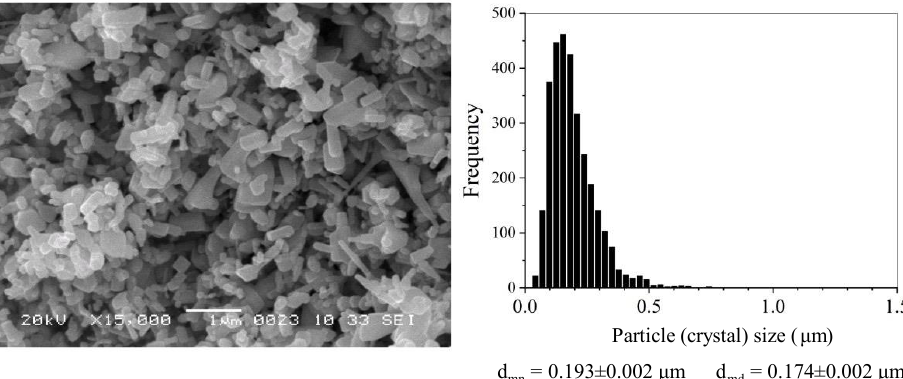
Figure 2. SEM image and crystal size distribution of ZnO powder at baseline.